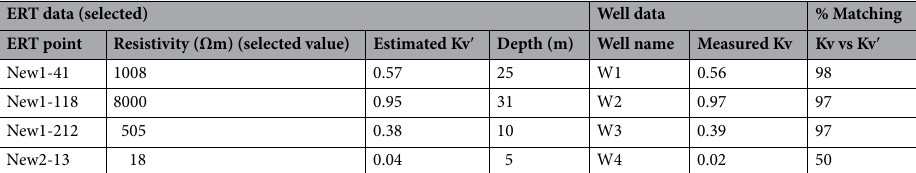
Table 2. Comparison between the measured and estimated Kv values for the selected data